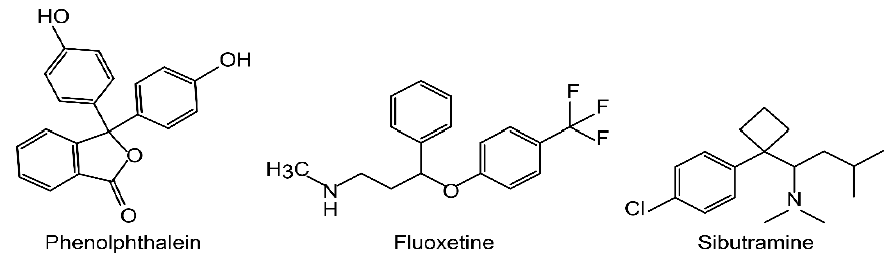
Figure 1. Chemical structure of fluoxetine, phenolphthalein, and sibutramine.